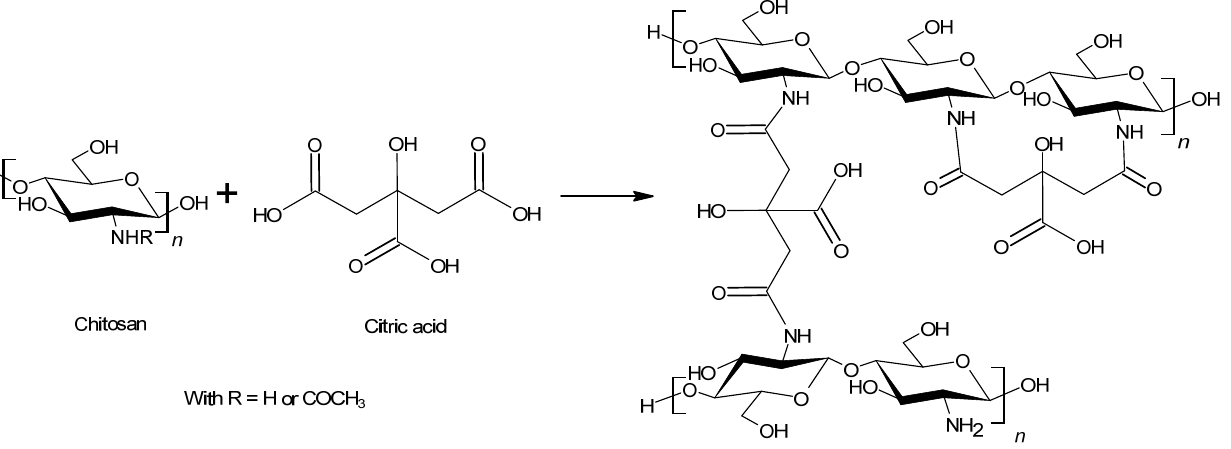
Figure 2. Covalent cross-linking reaction between chitosan and citric acid .